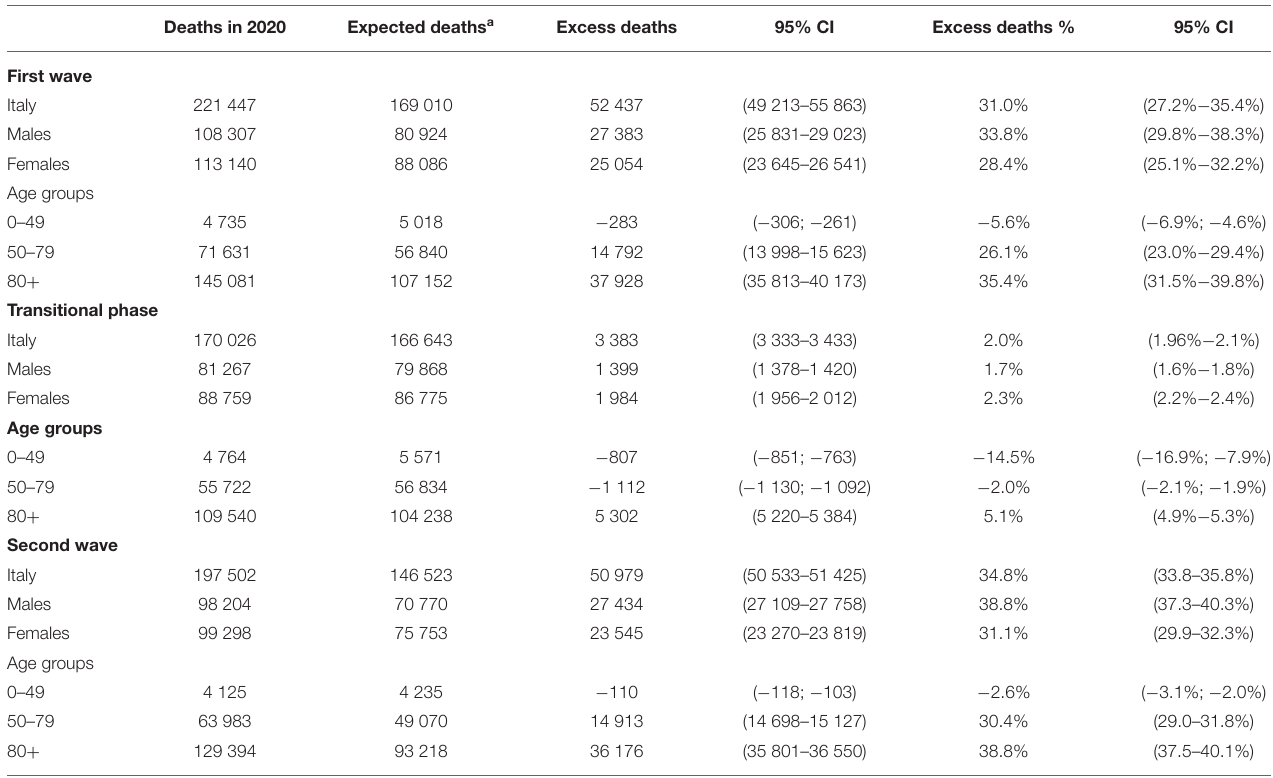
TABLE 2 | All-cause excess deaths estimates according to the the two waves and the transitional